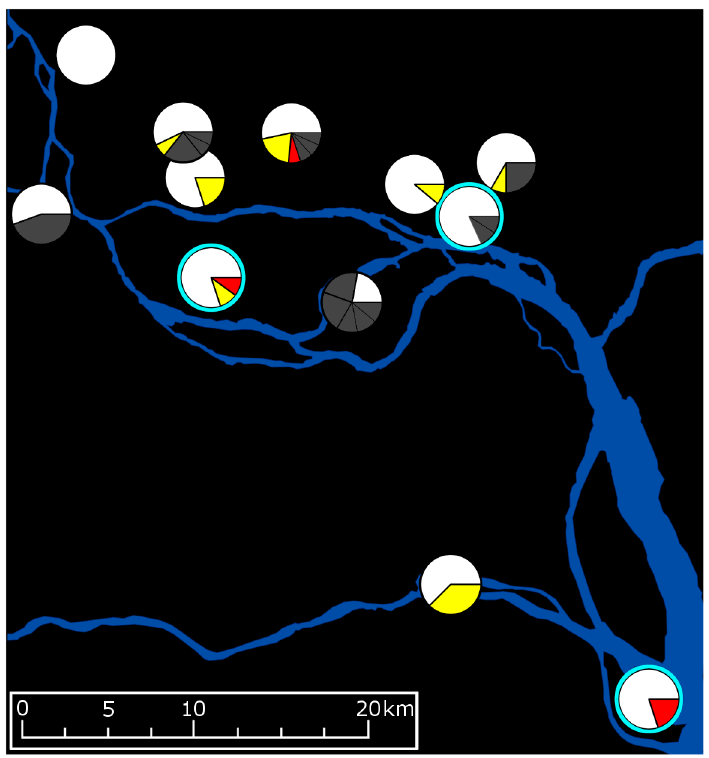
Fig 4. Locations of mtDNA and w AlbB haplotype variants. Pie charts represent mtDNA haplotypes, with the followinglegend:white = the single common haplotype;yellow = rare haplotypeA, 1 SNP; red = rare haplotypeB, 3 SNPs; dark grey = rare haplotypesof variabledivergence, each confinedto one sample site. One SNP in w AlbBwas found in three individualsfrom different sites, these are indicatedwith a blue ring.